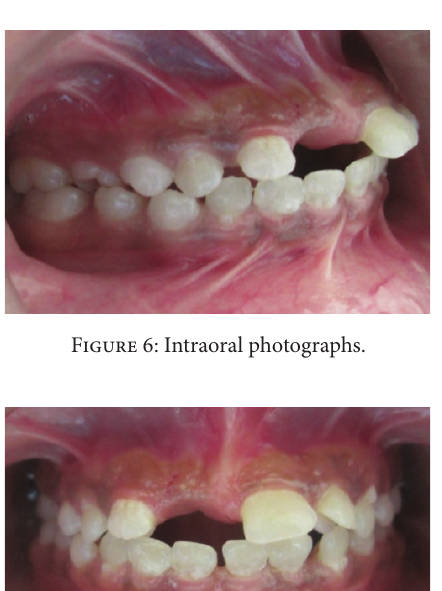
Figure 10: Mother’s OPG revealing short conical roots.